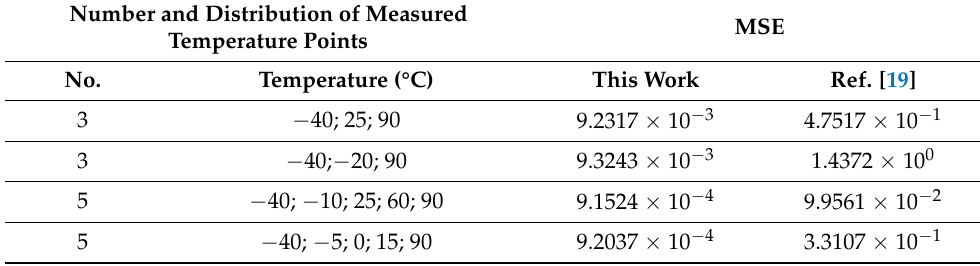
Table 1. Comparison results of models in different cases for power amplifiers (PA). Number and Distribution of Measured Temperature